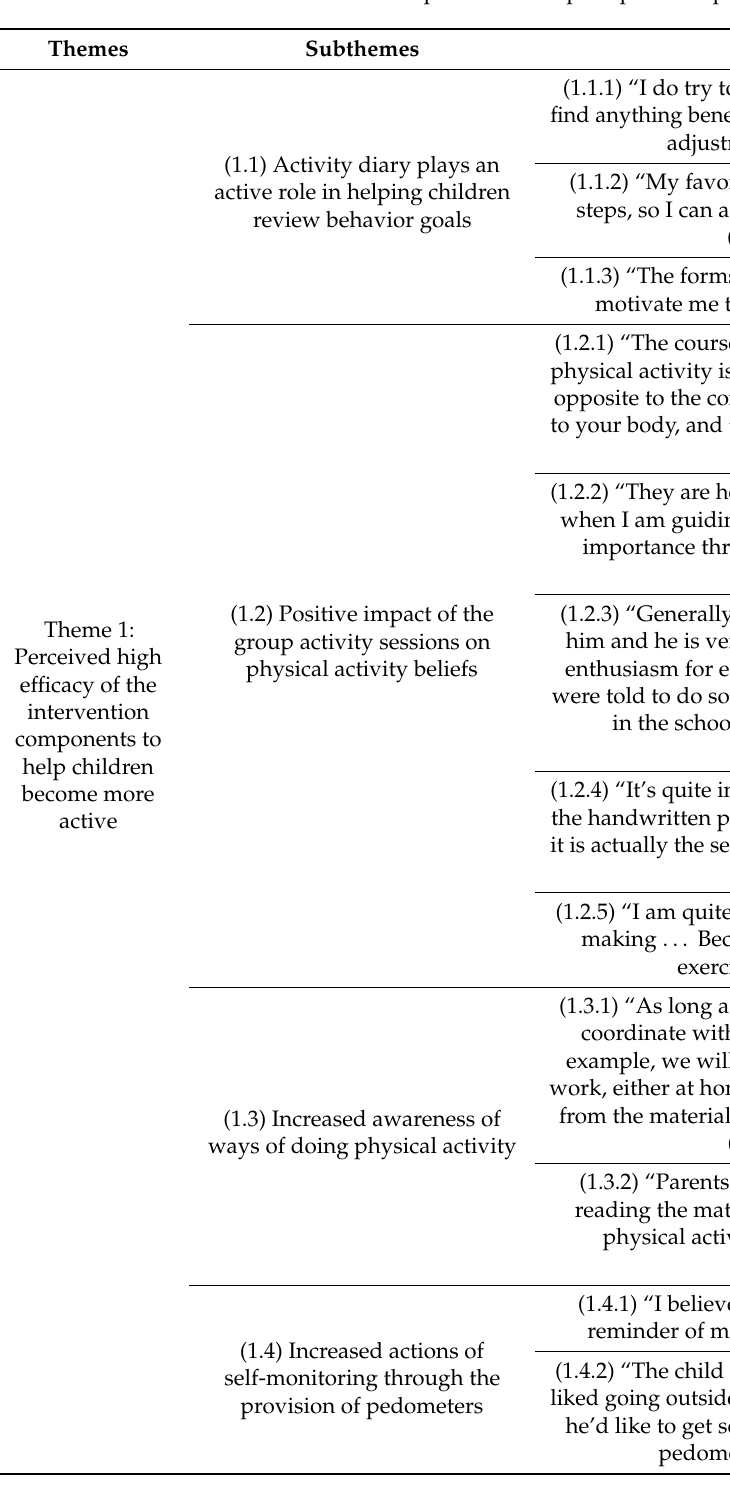
Table 3. Experiences and perceptions of participating in the